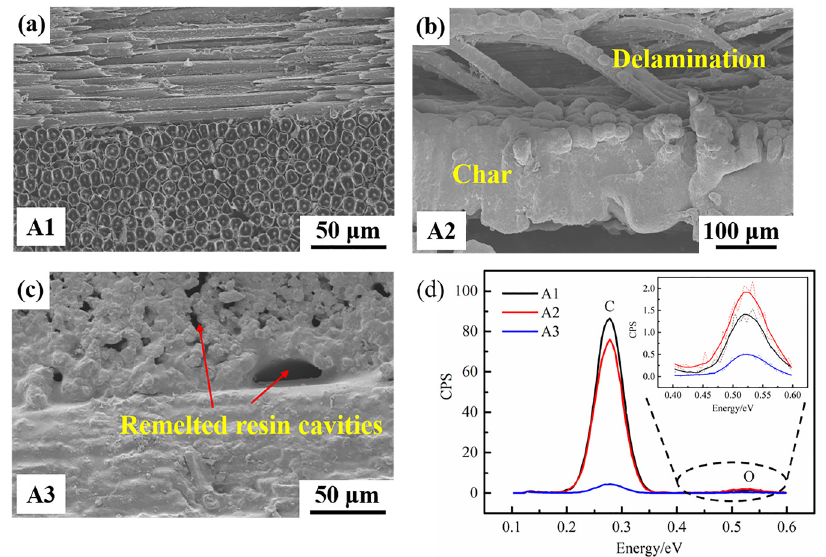
Figure 5. Micromorphology of the CF/PAEK cross section after the laser ablation test: ( a ) region A1; ( b ) region A2; ( c ) region A3; ( d ) EDS pattern of regions A1, A2, and A3.